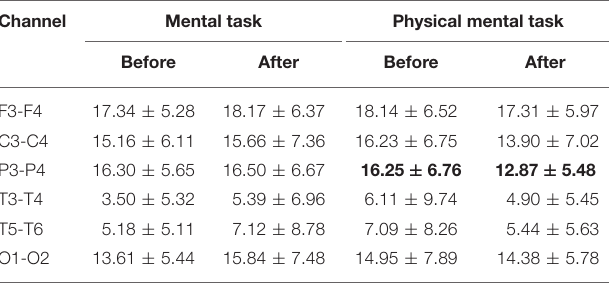
TABLE 4 | SCV β for mental and physical mental tasks. Channel